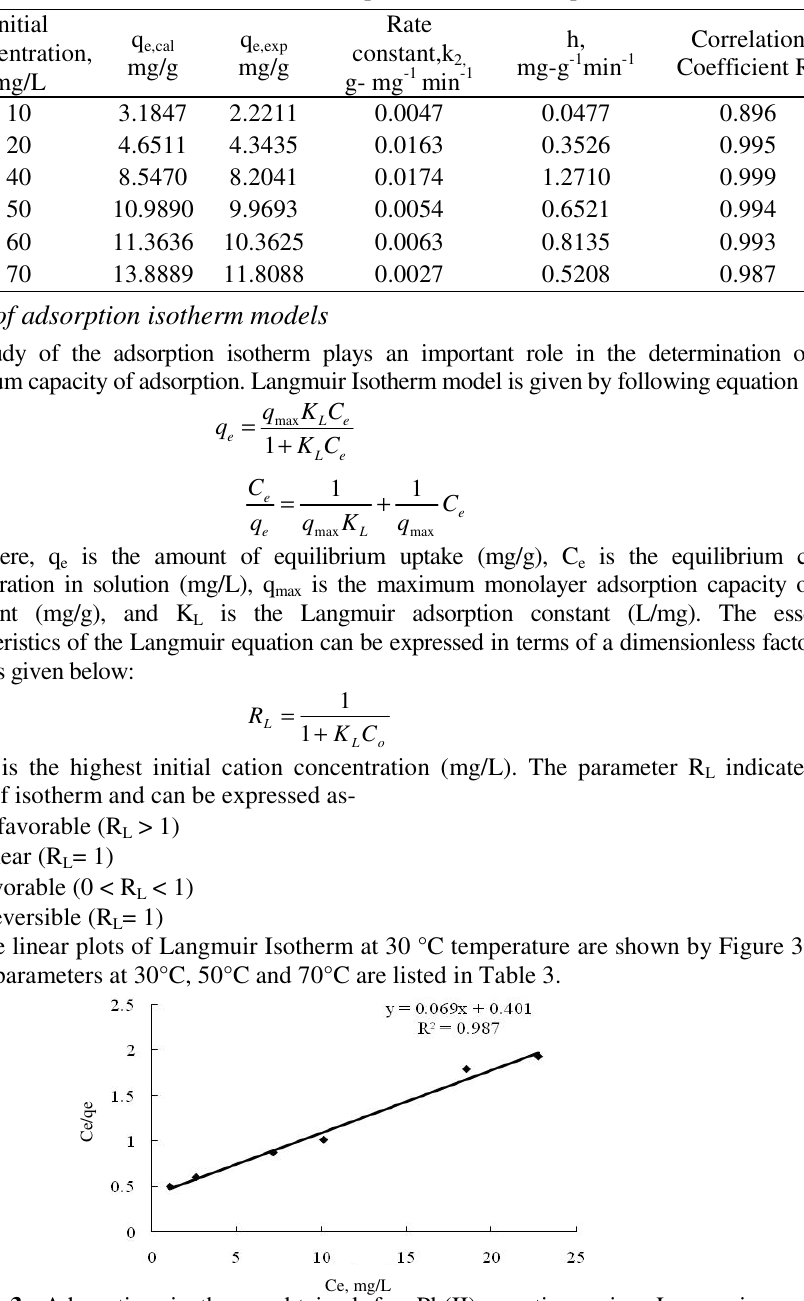
Table 2. Pseudo-Second order kinetic parameters for adsorption of Pb onto POFA